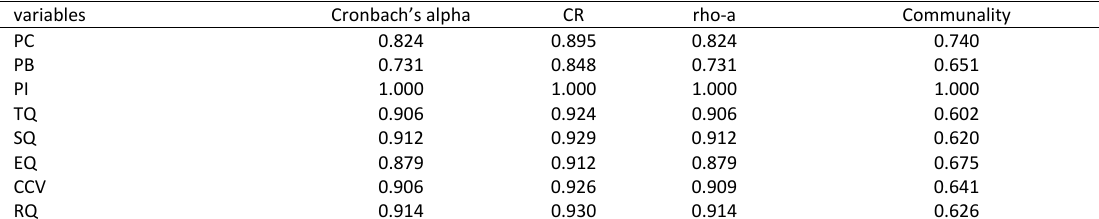
Table 1: Assessing the reliability of model variables